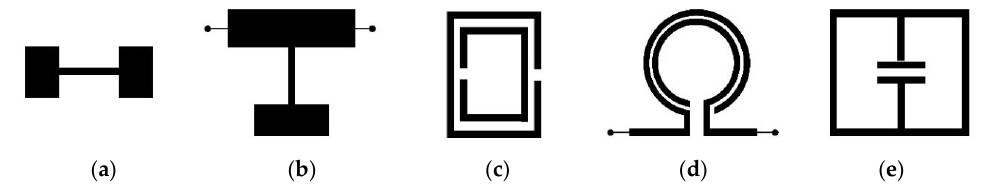
Figure 2. Typical topology of some electrically small metallic resonators useful for sensing. ( a ) Step impedance resonator (SIR), ( b ) step impedance shunt stub (SISS), ( c ) split-ring resonator (SRR), ( d ) open split-ring resonator (OSRR), ( e ) electric-LC (ELC).